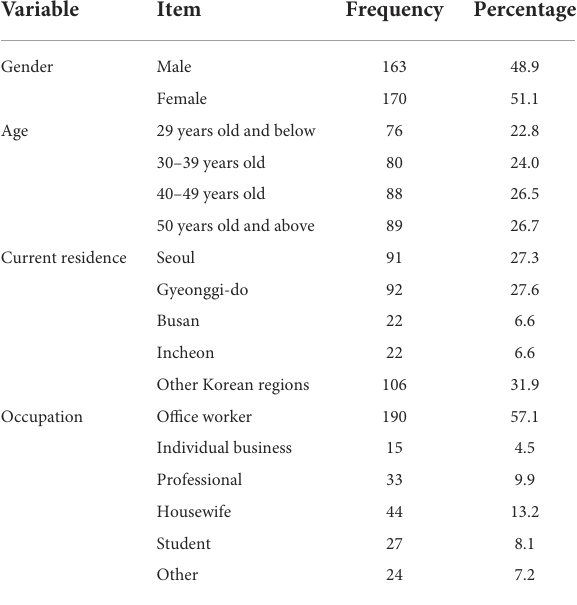
TABLE 1 Respondents’ demographic